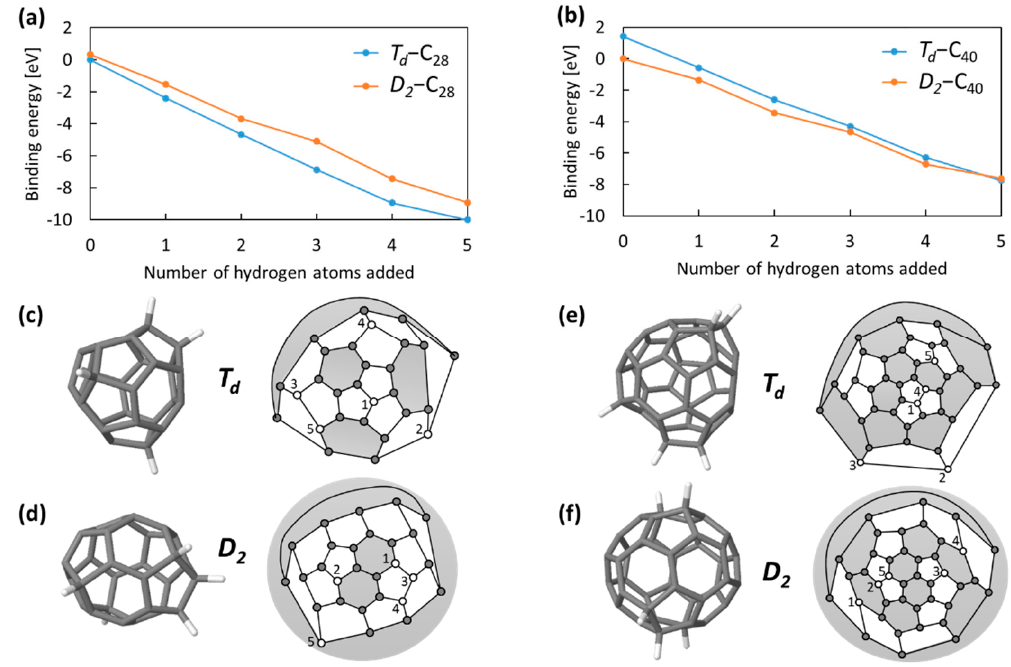
Figure 3. DFT-LDA hydrogen binding energy relative to the most stable isomer and isolated H 2 (eV) for ( a ) C 28 and ( b ) C 40 obtained by sequential hydrogenation. The T d ( D 2 ) isomer is given in blue (orange); symmetry notation refers to nonhydrogenated fullerene cage. ( c – f ) 3D molecular structures and Schlegel diagrams for C n H 5 . Grey and white represent carbon and hydrogenated carbon atoms, respectively. In the Schlegel diagrams, white circles indicate hydrogenated sites, and hexagons are shaded in grey. Numbering in Schlegel diagrams indicates the hydrogenation order. Hydrogen binds more strongly to the T d -C 40 isomer than the D 2 -C 40 (although it does not, this time, adopt the triple-pentagon tetrahedrally symmetric sites). This lowers